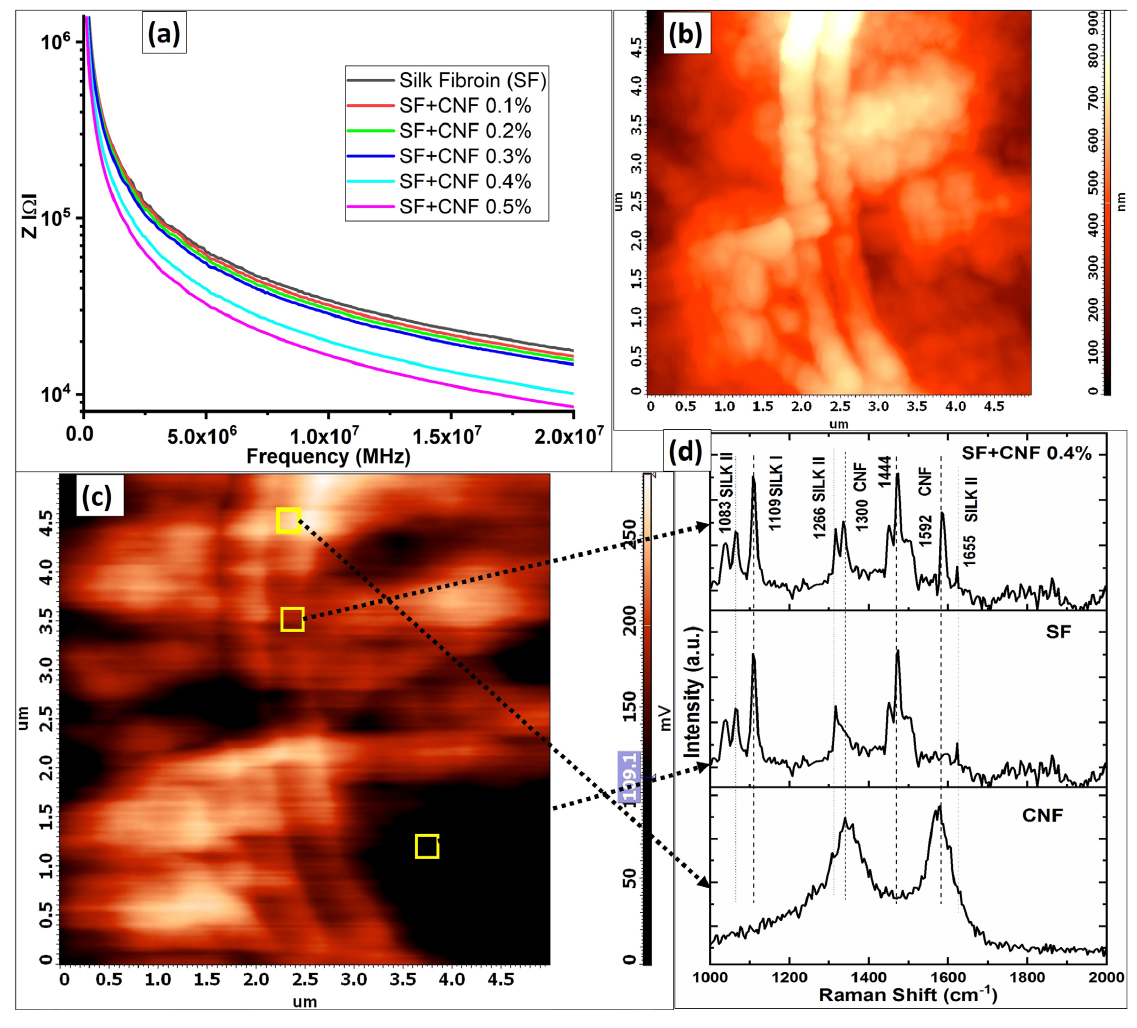
Figure 5. ( a ) Impedance vs. frequency graph for the SF sample having different CNF concentrations; ( b ) the AFM image of SF with CNFs network; ( c ) AFM image of SF with CNFs magnified in areas of conducting based on CNFs stacking; and ( d ) Raman analysis which represents a comparison of different elements of the AFM image for the pure CNFs, the pure SF and nanocomposite containing SF with CNFs density equal to 0.4%.